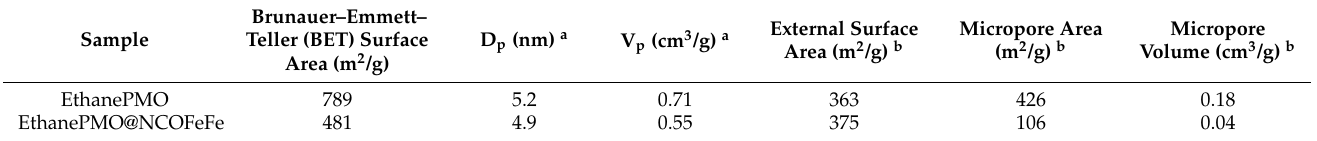
Table 1. Textural properties of EthanePMO and EthanePMO@NCOFeFe materials.